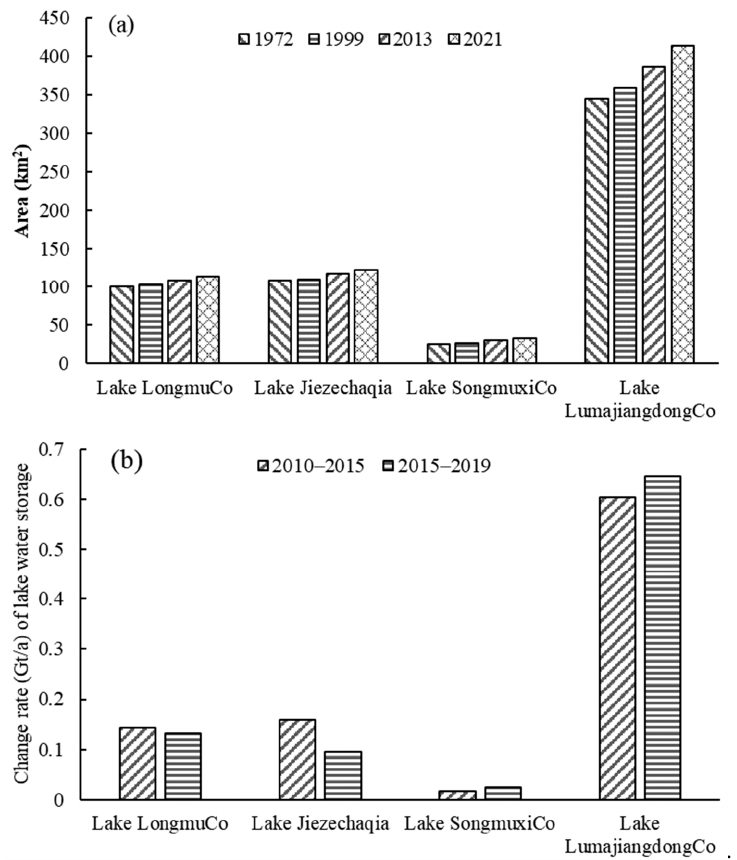
Figure 7. Comparison of area ( a ) and water storage ( b ) changes of Lake LongmuCo, Lake Jiezechaqia, Lake SongmuxiCo, and Lake LumajiangdongCo.